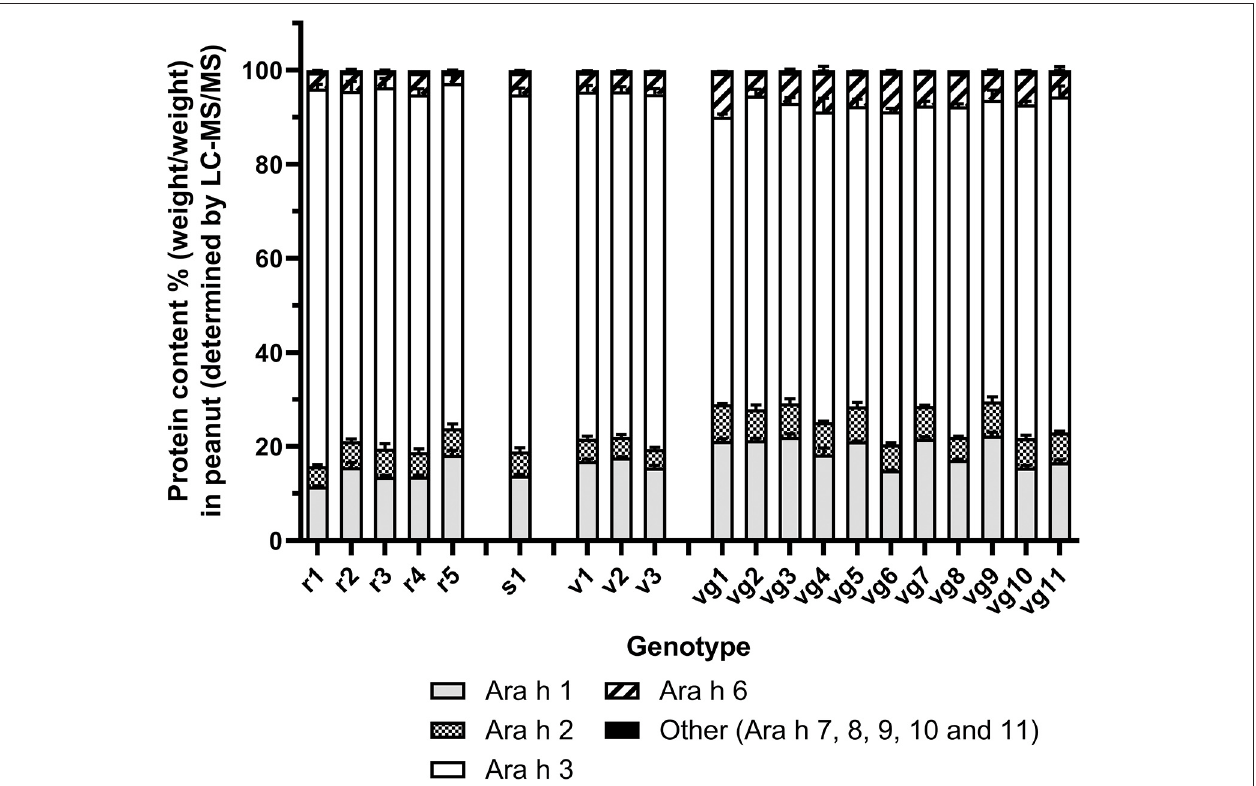
FIGURE 1 | Protein quantitation of Ara h 1, 2, 3, 6, and other (Ara h 7–11) as determined by shared peptide quantitation. Trypsin-digested protein spiked with glycogen phosphorylase peptides was analyzed by LC-MS/MS. Allergens were quantified by the shared peptides ( Supplementary Table S5A ) and normalized to glycogen phosphorylase. Stacked bar histogram plots show the mean protein content % [weight (allergen)/weight (total allergen)] in peanut for each allergen family and standard error of the mean (bar) from two biological replicates, which had two technical replicates for each sample (left y -axis). Each peanut genotype analyzed is shown on the x